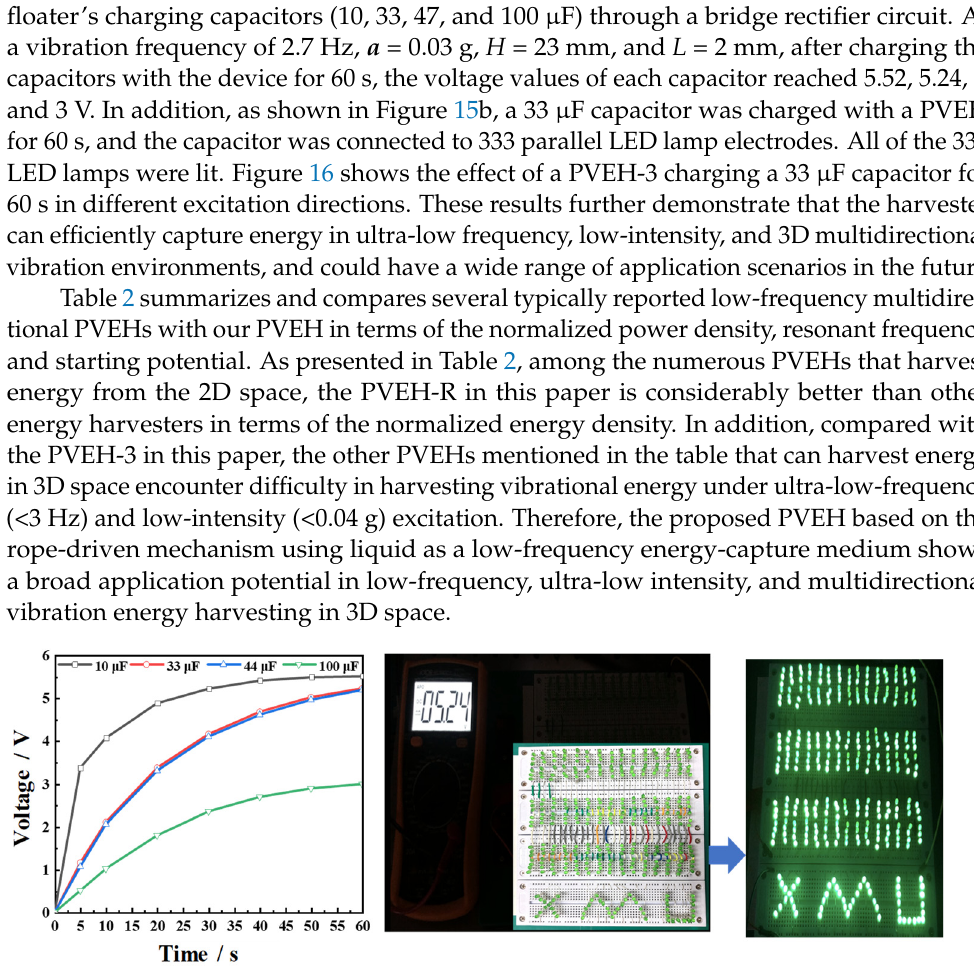
Figure 14. The effect of the liquid height on the PVEH output characteristics.